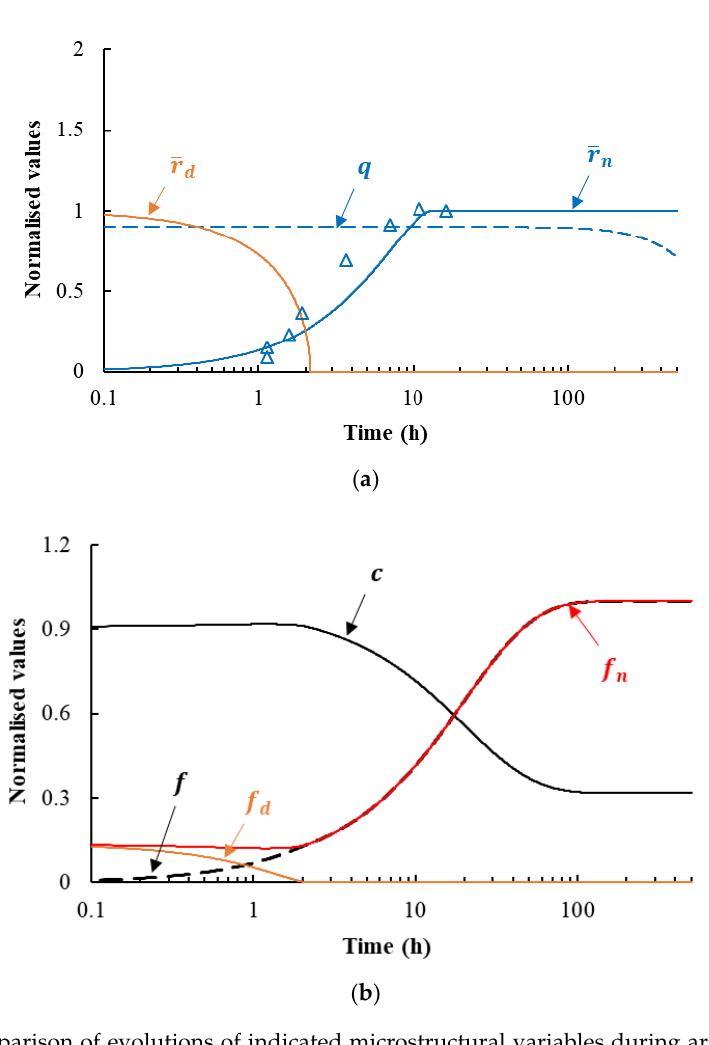
Figure 5. Comparison of evolutions of indicated microstructural variables during artificial ageing of AA2198 at 155 °C from experiments (symbols [35]) and modelling results from Table 3 (lines). ( a ) Variables of dimensions of precipitates; ( b ) Variables of volume fractions and solid solution.